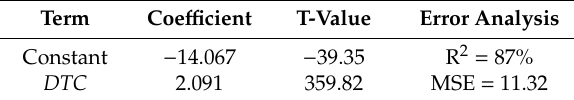
Table 2. Simple linear regression model properties.